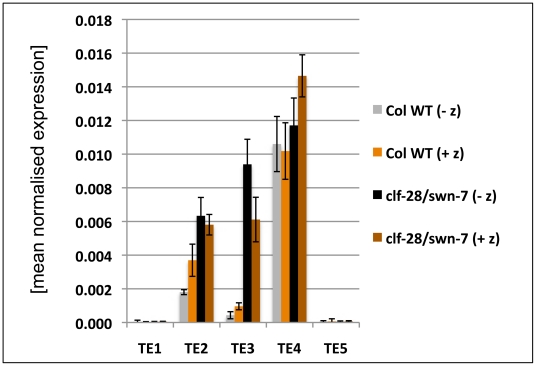
Expression analysis of transposable element genes.The expression of several transposable element genes was analysed in 9 d old wildtype and clf-28/swn-7 seedlings by qRT-PCR. Plants were grown on media with (+ z) and without the DNA methyltransferase inhibitor zebularine (− z). Expression values were normalized to At5g60390 (EF-1α). [TE1 (AT3G28400; hAT transposase), TE2 (AT3G21020; copia element), TE3 (AT3G21040; copia element), TE4 (AT3G43690; copia element), TE5 AT4G02960; copia element)].